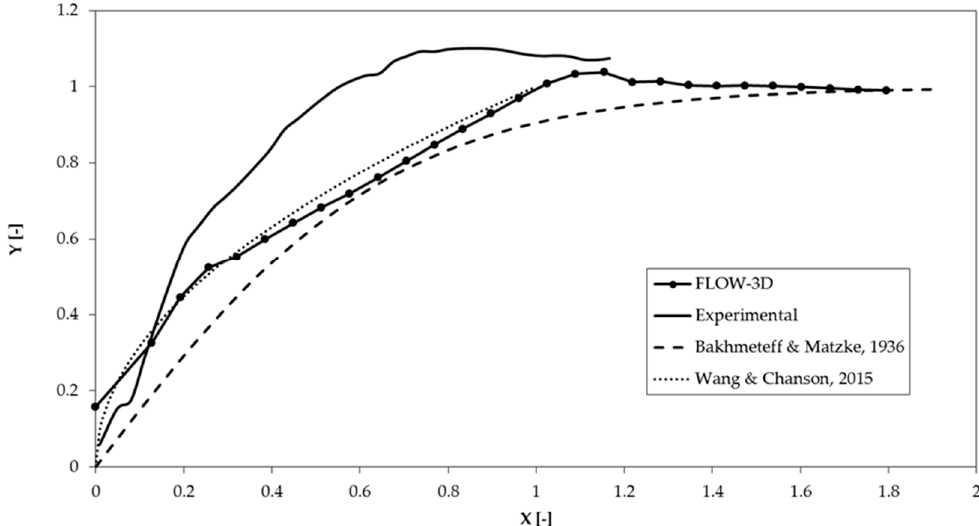
Figure 4. Dimensionless free surface profile of the hydraulic jump performed by the numerical and physical models, and contrast with data by Bakhmeteff and Matzke [56] and Wang and Chanson [8]. It should be noticed that near the origin ( X = 0), that is, close to the hydraulic jump toe position,